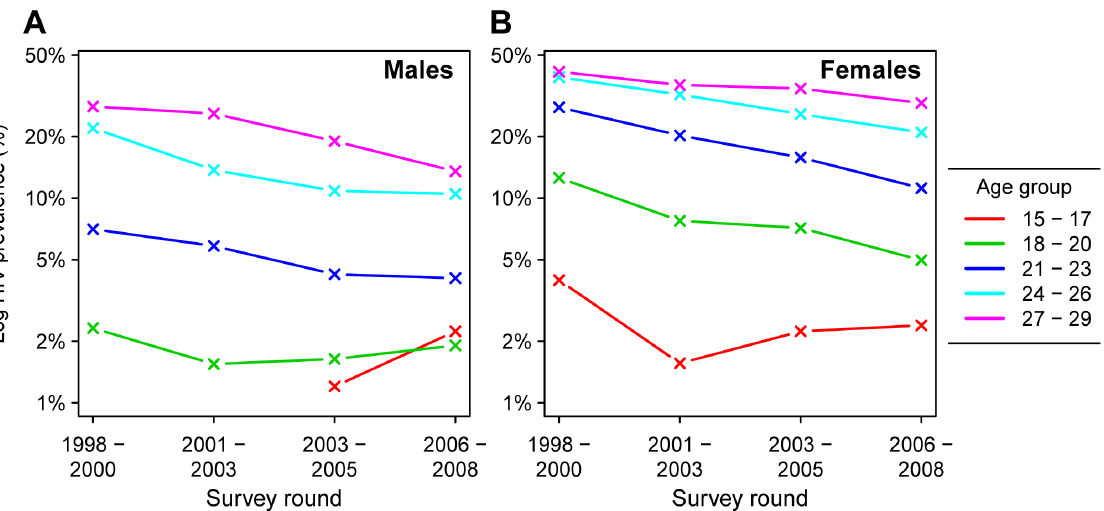
Figure 1. HIV prevalence in adolescents and young adults in the Manicaland HIV/STD Prevention Project. Age-specific HIV prevalence for males (panel A) and females (panel B) by 3-year age groups. Prevalence is represented on the logarithmic scale to illustrate trend at low prevalence levels.